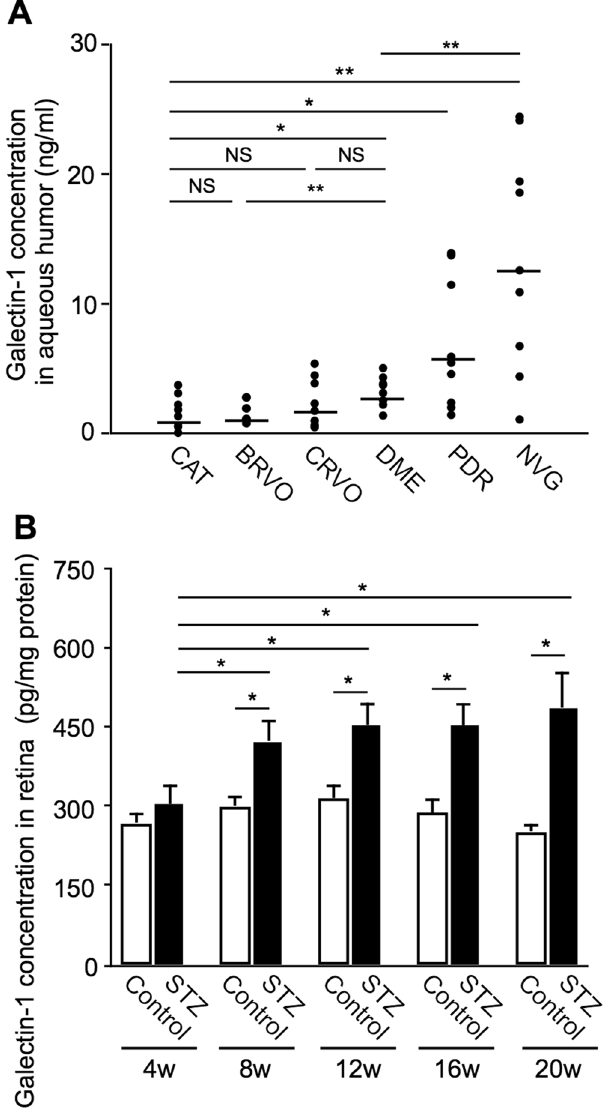
Figure 1. Elevation of galectin-1 protein levels selectively in eyes with DR. ( A ) Protein levels of galectin-1 in eyes with CAT (n = 8), DME (n = 7), PDR (n = 9), NVG (n = 9), BRVO (n = 7), and CRVO (n = 10). Black symbols indicate individual samples in each group with a bar showing the average. ( B ) Galectin-1 protein expression in retinal tissues from mice with STZ-induced diabetes (n = 6 per group). * p < 0.05, ** p <